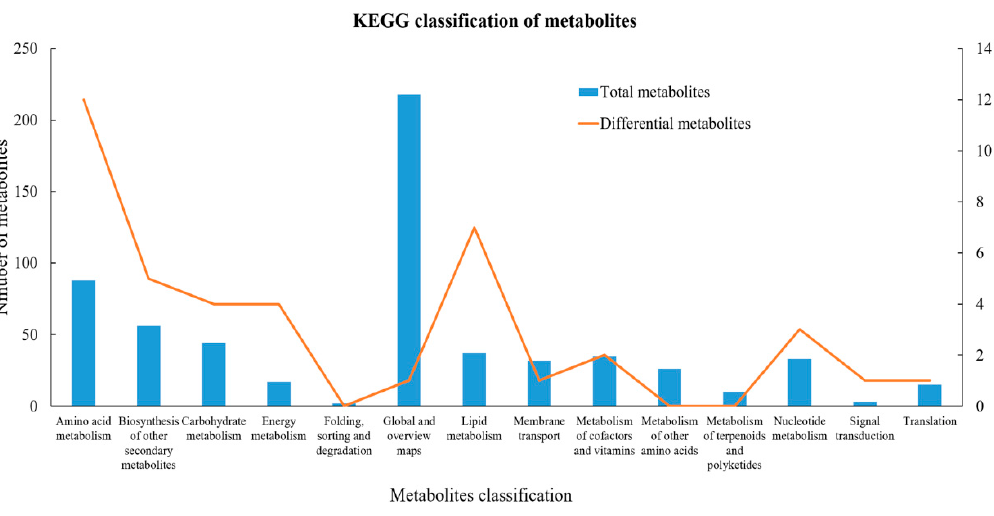
Figure 5. KEGG annotation analysis of metabolites in pea intercropped tea plants.